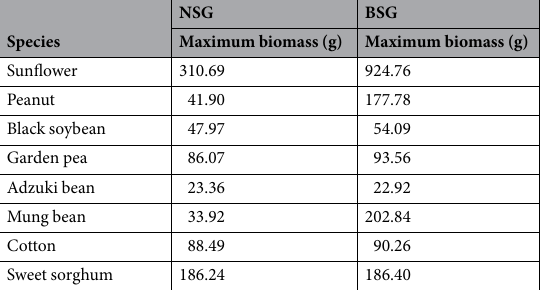
Table 3. Estimated value of maximum biomass of the new and beta sigmoidal growth models for the growth datasets of crop species. NSG and BSG represent the new sigmoidal growth model and the beta sigmoidal growth model in Eq. (4),